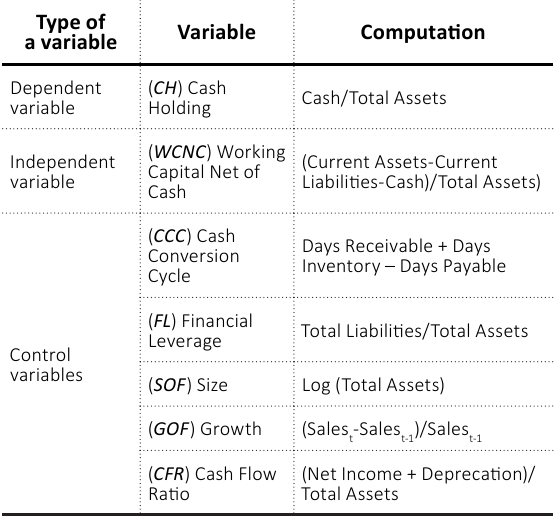
Table 2. Variable type, denomination and